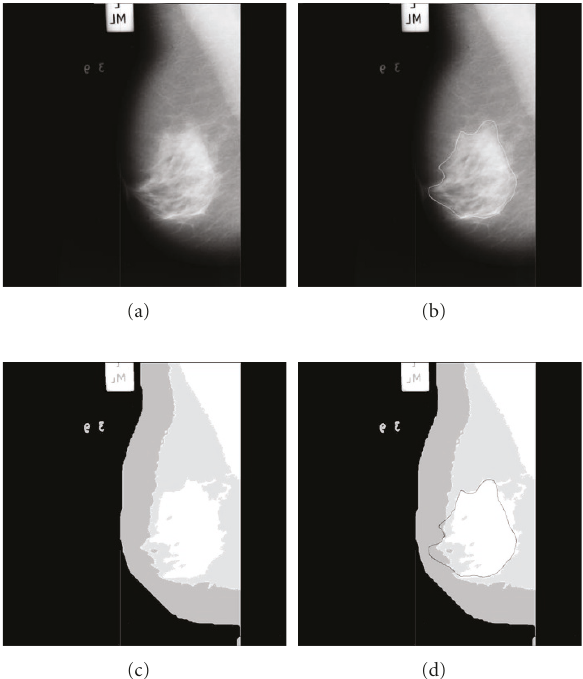
Figure 5: Segmentation results: (a) original mammogram mdb041; (b) radiologist’s manual segmentation; (c) obtained segmentation with initialization INIT A and ICM algorithm (10 iterations); (d) obtained segmentation compared to radiologist’s manual segmen- tation ( ρ = 0 . 77).